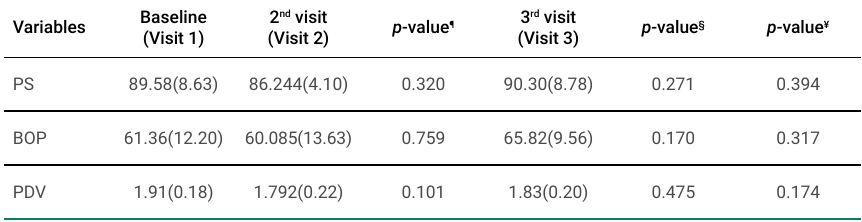
Table 2. Changes in periodontal parameters from baseline to 6 weeks after bond-up